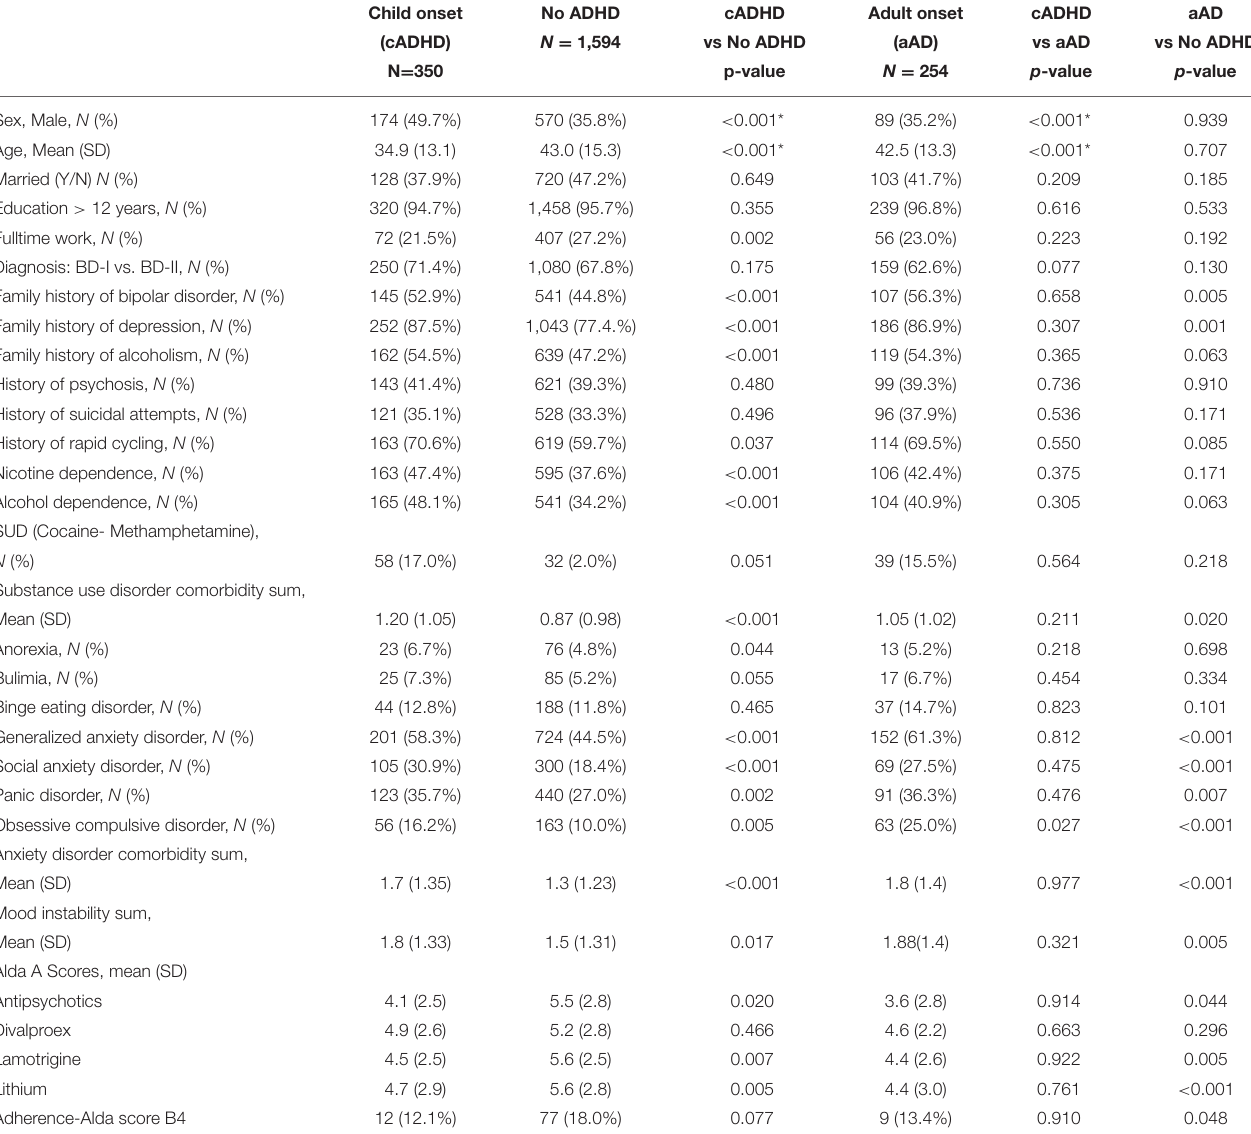
TABLE 1 | Comparison of demographic and clinical variables between BD patient subgroups: BD + cADHD, BD + aAD, and no-ADHD. Child onset No ADHD cADHD Adult